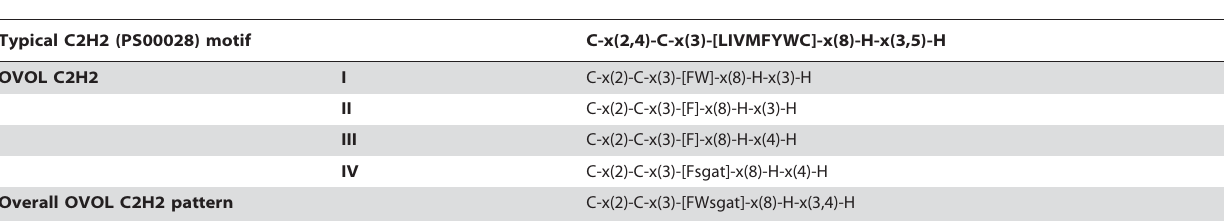
Table 5. Pattern comparisons for four C2H2 motifs from OVOL proteins. Exceptional residues are marked by lower case.